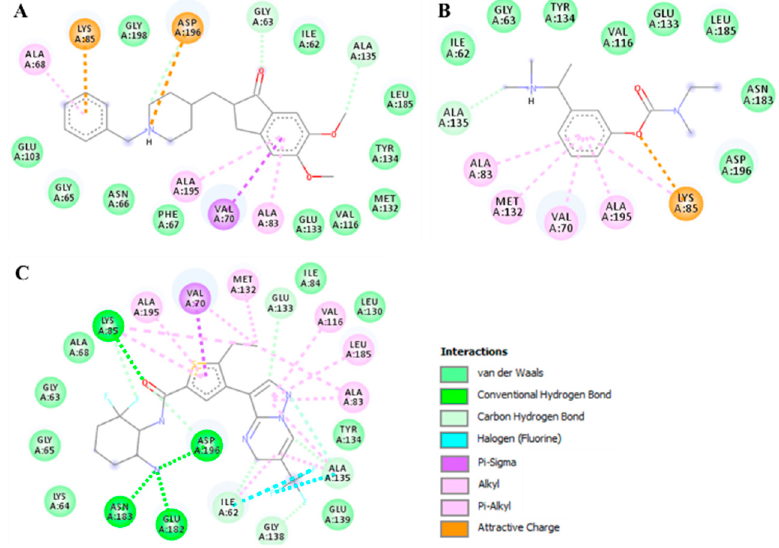
Figure 8. 2D structural representation of MARK4 residues interacting with ( A ) DP ( B ) RT, and ( C ) standard MARK4 inhibitor (5RC, [48]).